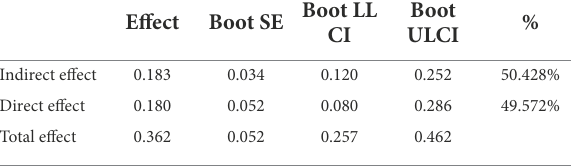
TABLE 5 Results of indirect effects, direct effects, and total effects.